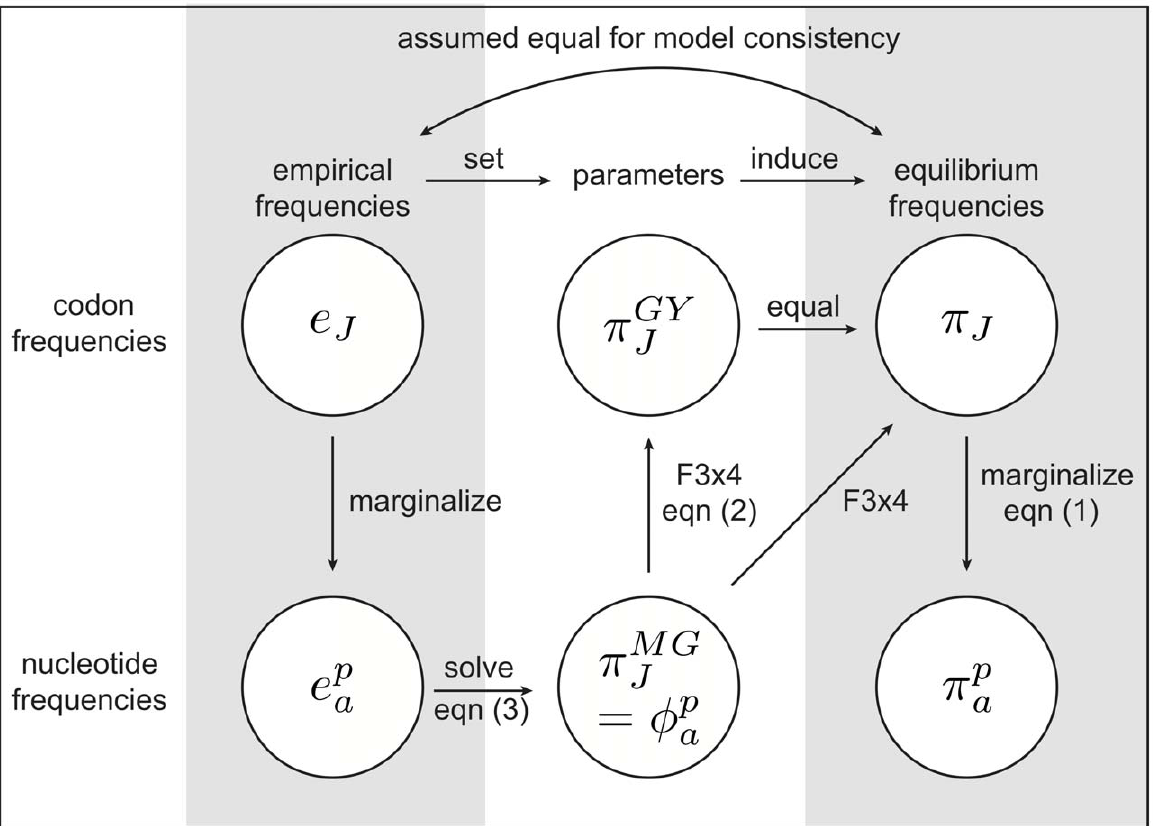
Figure 1. Relationships between empirical frequencies, frequency parameters and equilibrium frequencies in codon models.